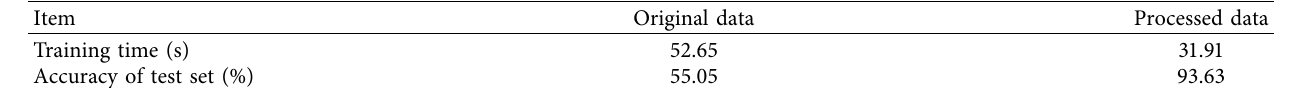
Figure 18: Visualizations of dimensionality reduction of (a) original data and (b) processed data. Table 4: Impact of DIT-FFT data processing on fault